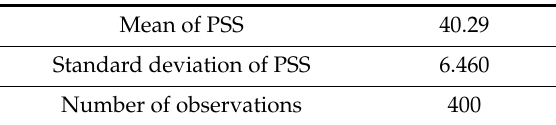
Table 13. Descriptive statistic of PSS.